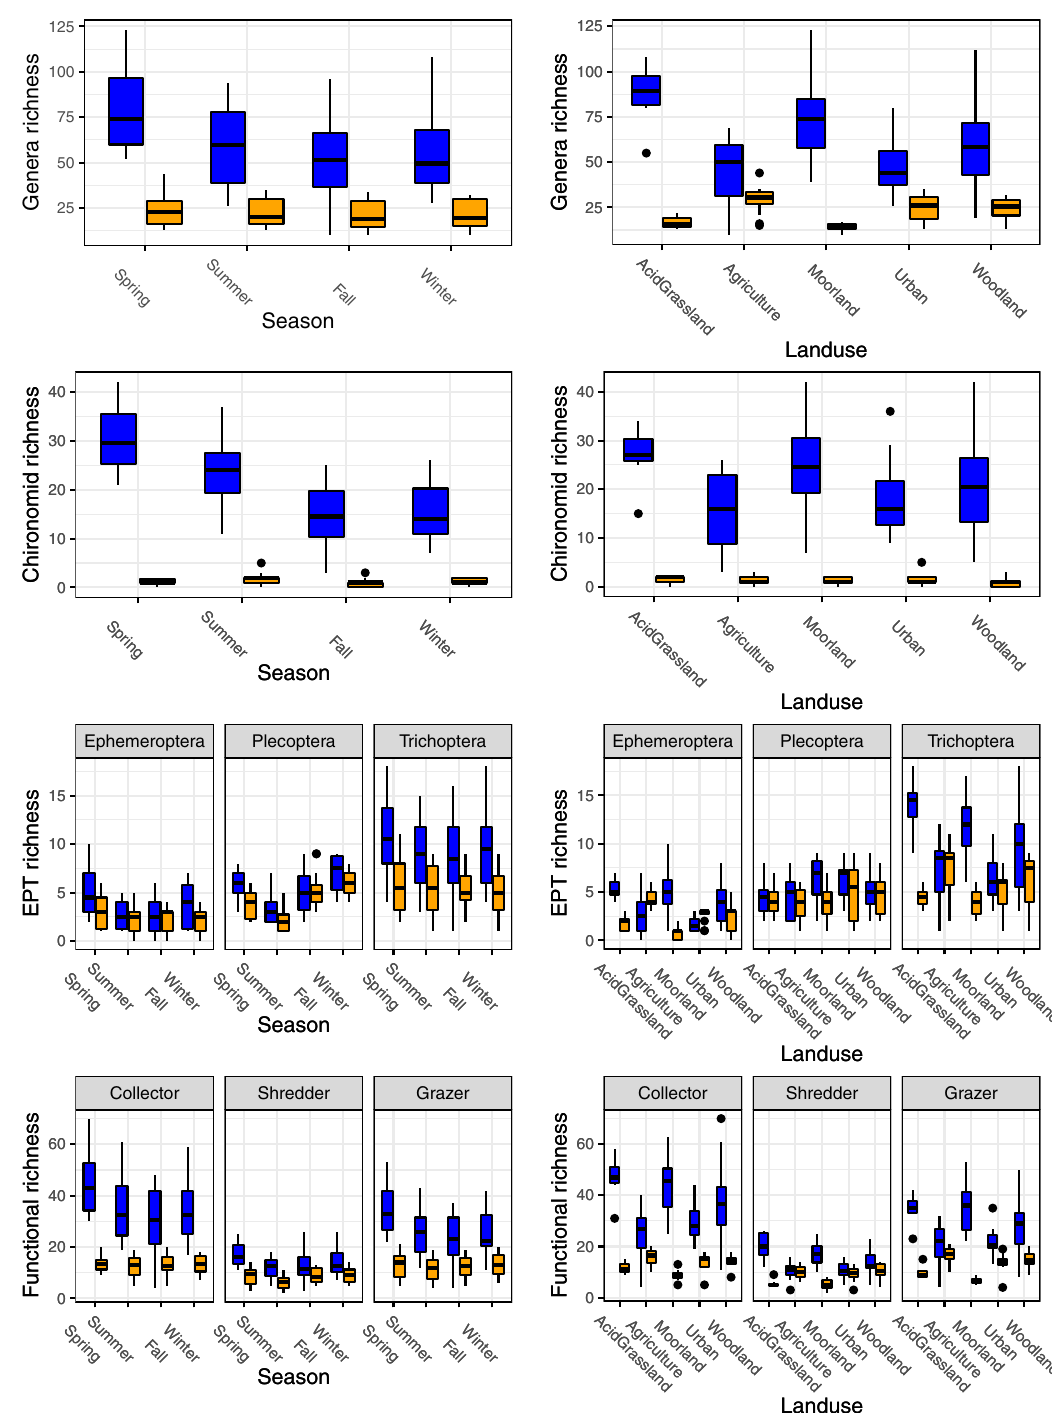
Fig. 4 Genera, Chironomidae, EPT and functional spato-temporal richness patterns for eDNA and traditional methods. Box plots showing the richness diversity per season (left panels), and landuse (right panels) for genera (top), Chironomidae (second from the top), EPT (second from the bottom) and functional diversity (bottom). Blue indicates eDNA derived data and orange indicates traditional method derived data. Error bars are drawn to 1.5 * inter- quartile range (IQR), with outlier points being the data outside the 1.5 * IQR range. Sample sizes were 56 for eDNA (average of each sites ’ 3 replicate samping) and 56 for traditional